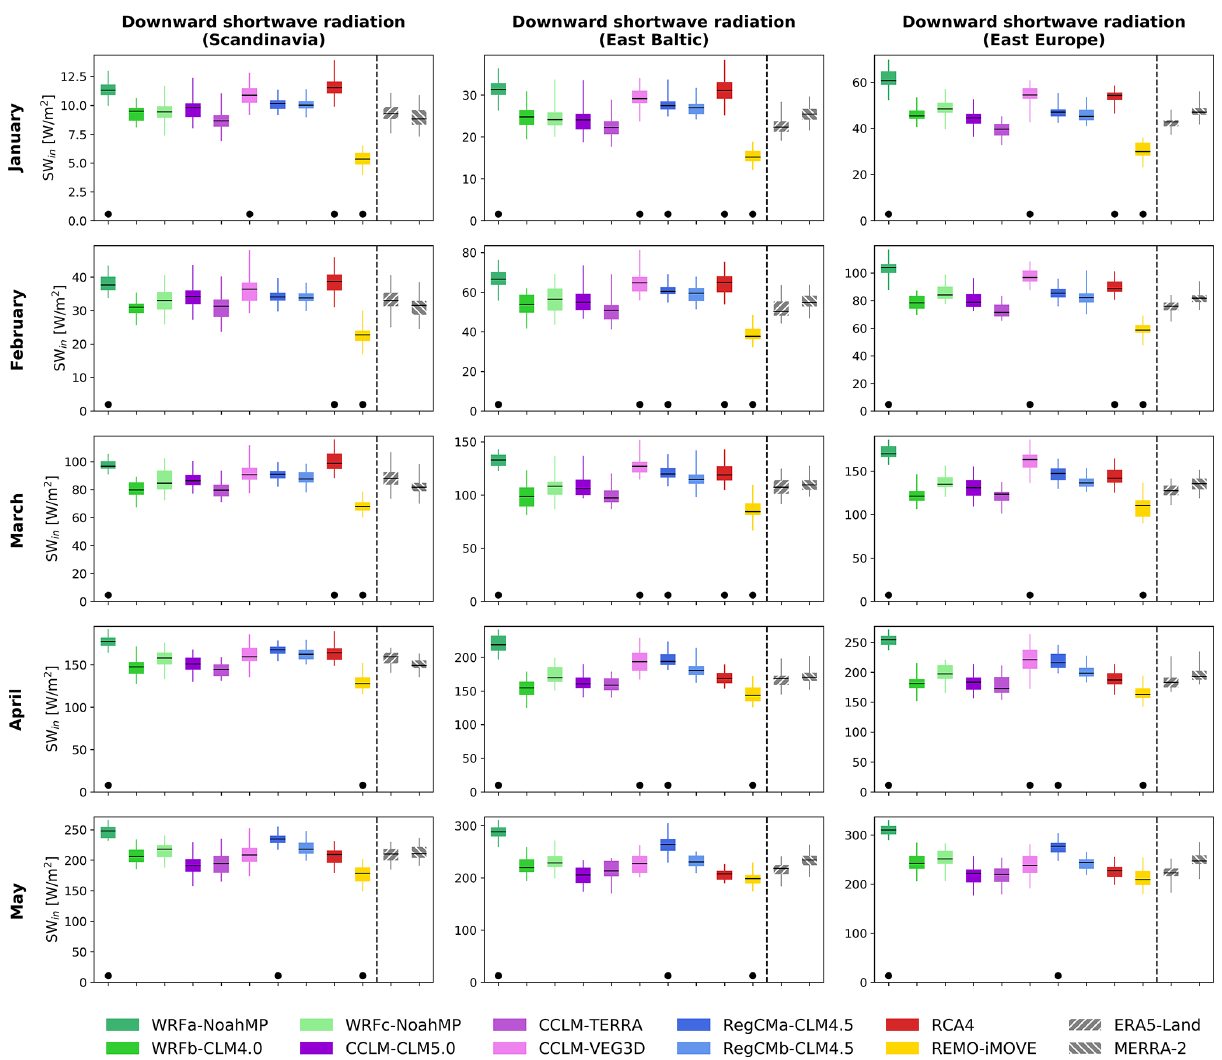
Figure 6. Downward surface shortwave radiation for the 10 RCMs, MERRA-2 and ERA5-Land for January to May. The box-and-whisker plots show the interannual variability in downward shortwave radiation over 1986–2015, with the bar representing the median, boxes the interquartile range, and whiskers the minimum/maximum values. Dots indicate models lying outside the range of the reference datasets of MERRA-2, ERA5-Land and MODIS (i.e., the 25th (75th) model percentile is higher (lower) than the highest 75th (lowest 25th) quantile of the reference datasets). See Fig. S5 in the Supplement for the same figure will all datasets averaged over the time period